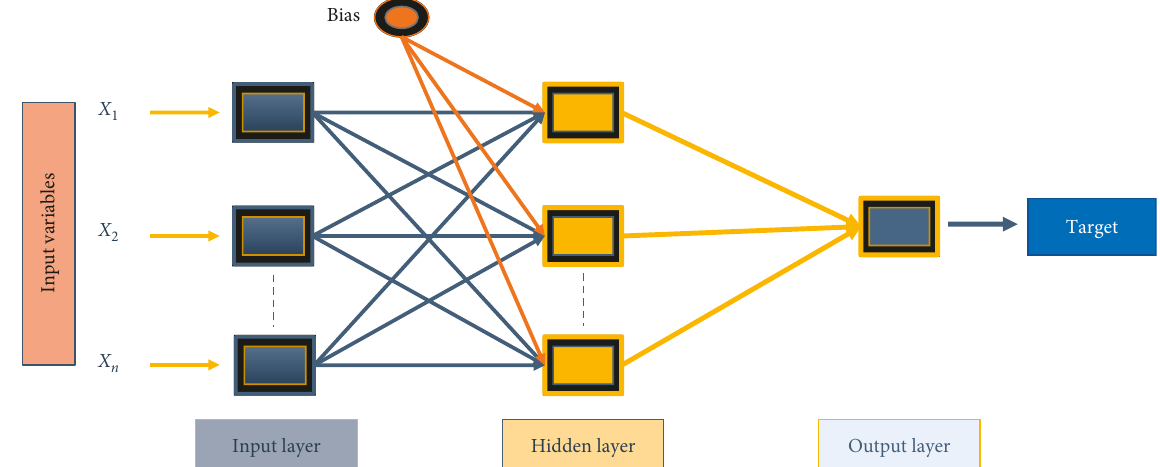
Figure 2: The basic ELM topology.